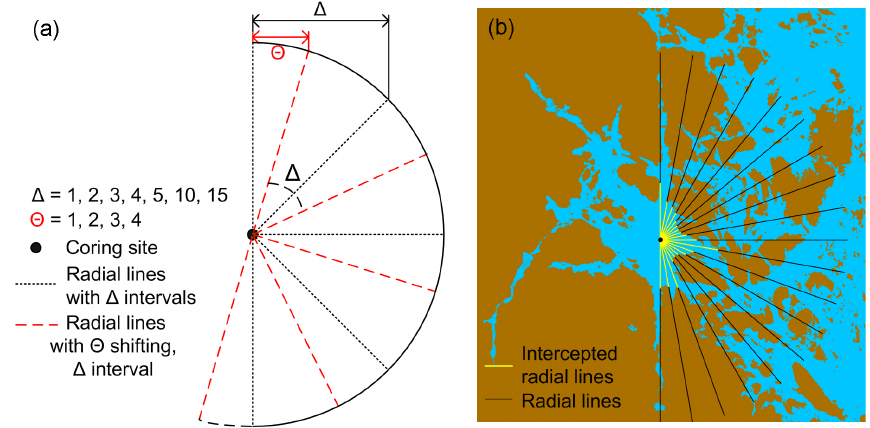
Figure 3. (a) Illustration of the 180 ◦ radiating lines, the intervals ( (cid:49) ), and the shifting angles ( (cid:50) ). (b) Black and yellow lines represent the 8km long radial lines and the intercepted lines for openness index